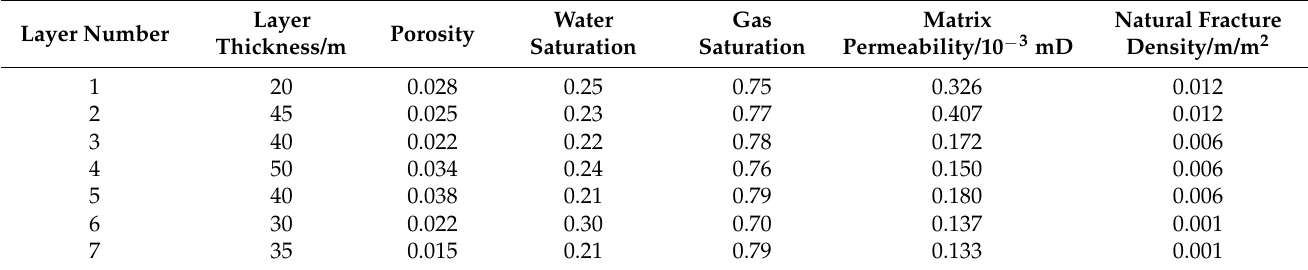
Table 2. Properties of each layer and development of natural